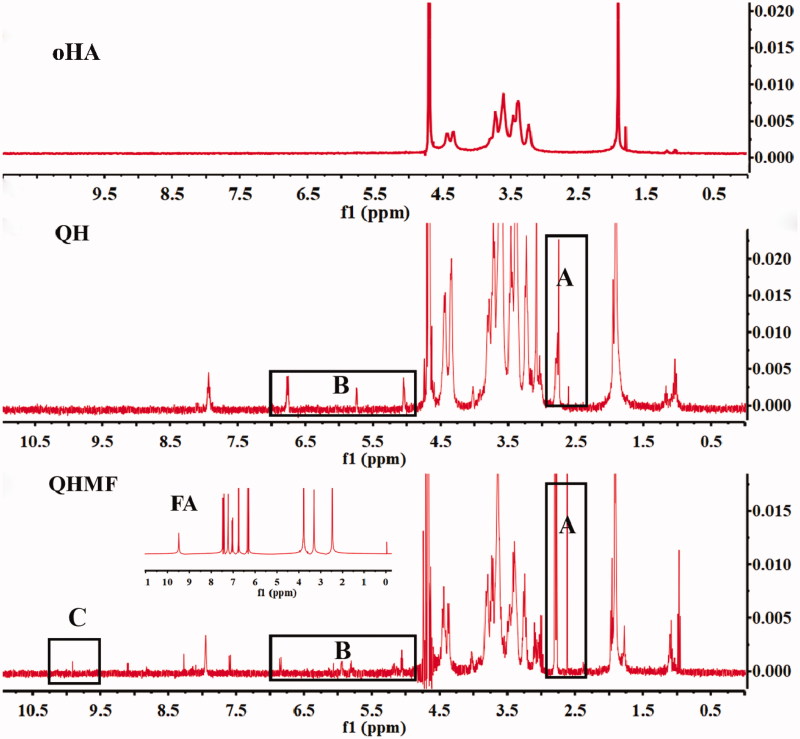
The 1H NMR spectra of QH and QHMF.